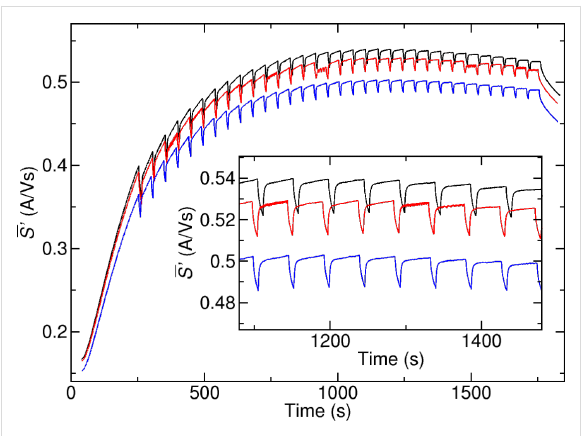
Figure 5: Time-dependent rate of change of conductance for Pt–C deposits - The GA is applied for the optimization of conductance during post-irradiation with electrons ( U = 5 kV, I nominal = 6.3 nA). Reference sample (blue): t D = 1 μ s, p x = p y = 40 nm, sample for GA dwell-time optimization (red): t D = 0.2–1500 μ s, p x = p y = 40 nm, sample for GA pitch optimization (black): t D = 1 μ s, p x , p y = 10–100 nm. A variation